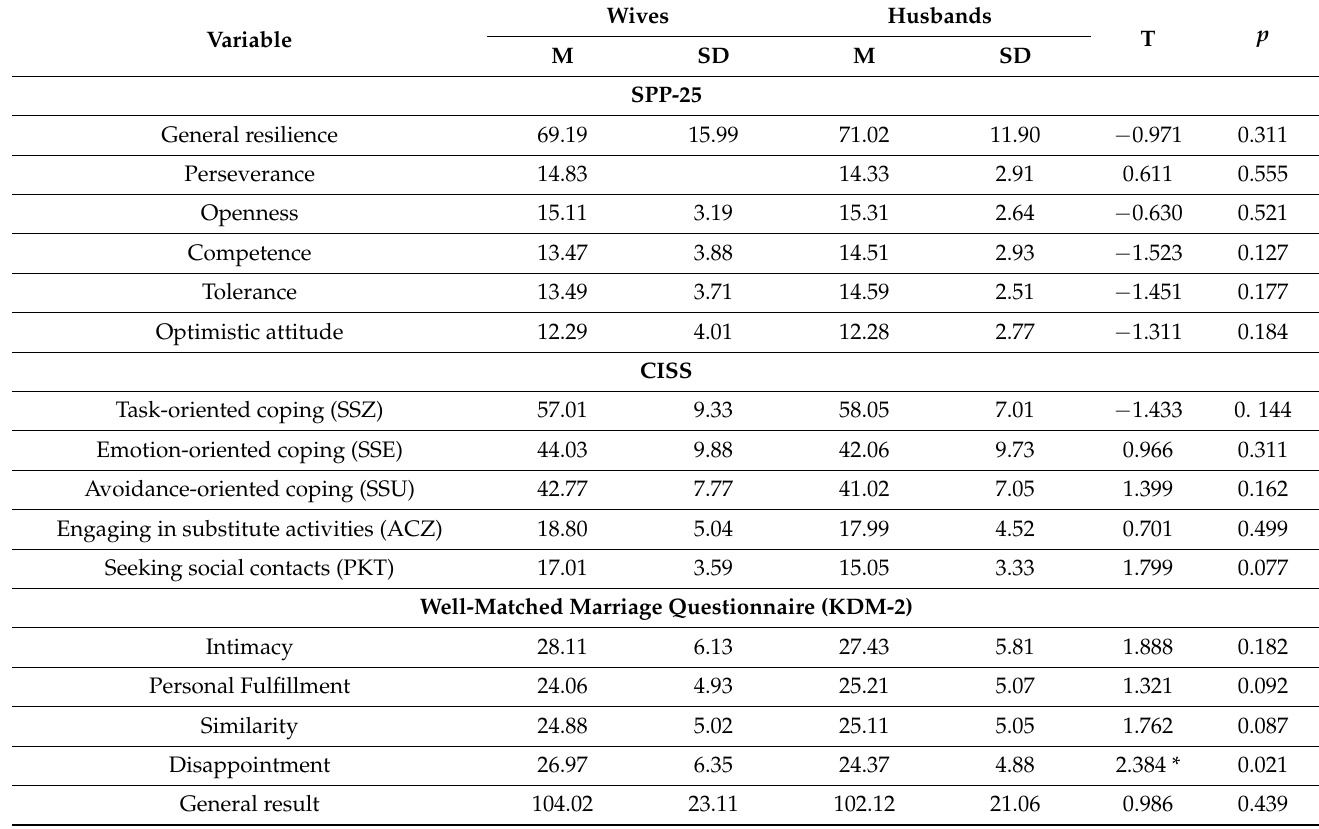
Table 1. Comparative analysis of resilience, stress coping styles and marital satisfaction among wives and